Question: Looking at the figure, what chart type is it?
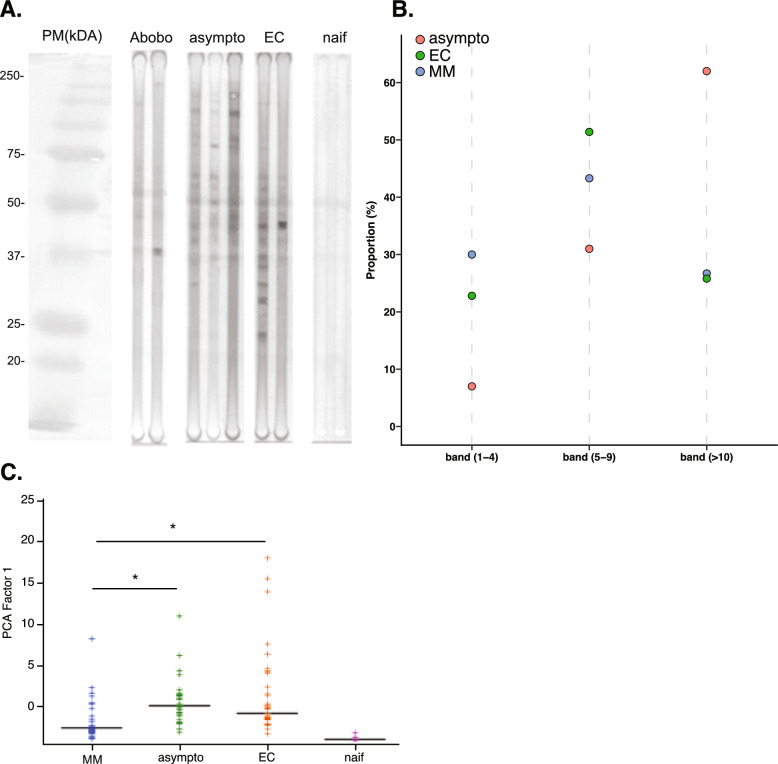
Answer: scatter